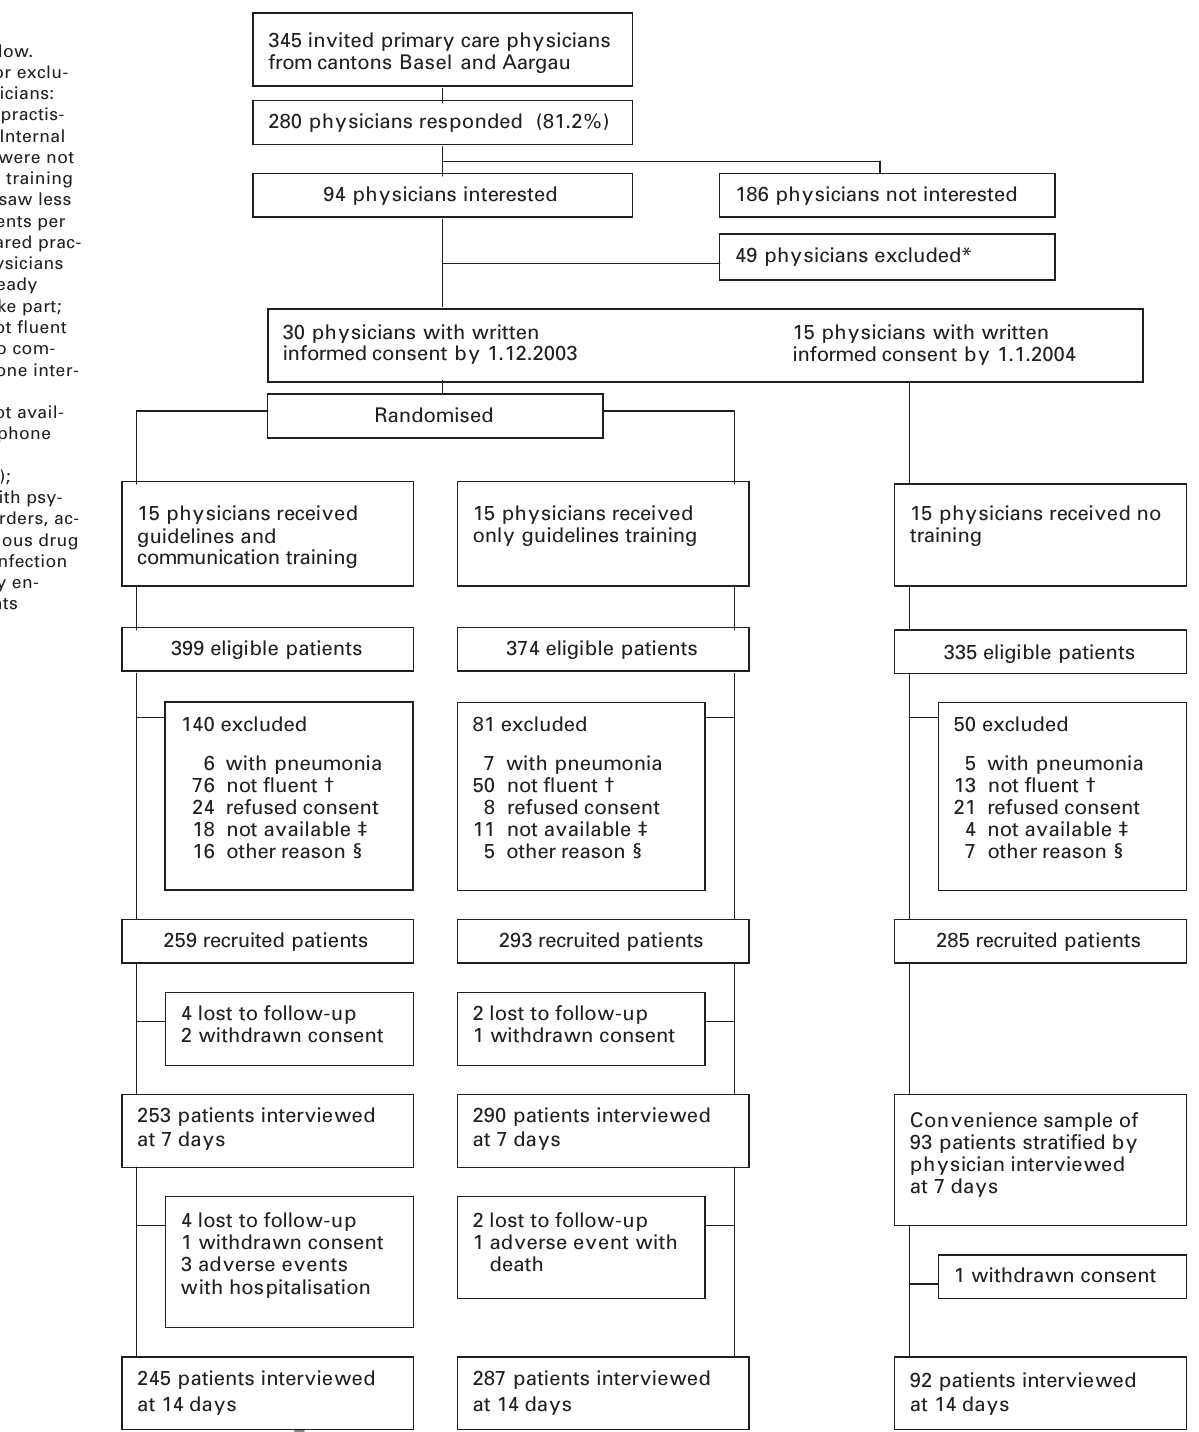
Figure 1 Participant flow. * Reasons for exclu- sion of physicians: 26 were not practis- ing General/Internal Medicine, 7 were not available for training seminars, 4 saw less than 30 patients per week, 12 shared prac- tice with physicians who had already agreed to take part; † Patients not fluent in German to com- plete telephone inter- views; ‡ Patients not avail- able for telephone interviews (eg vacation); § Patients with psy- chiatric disorders, ac- tive intravenous drug users, new infection of previously en- rolled